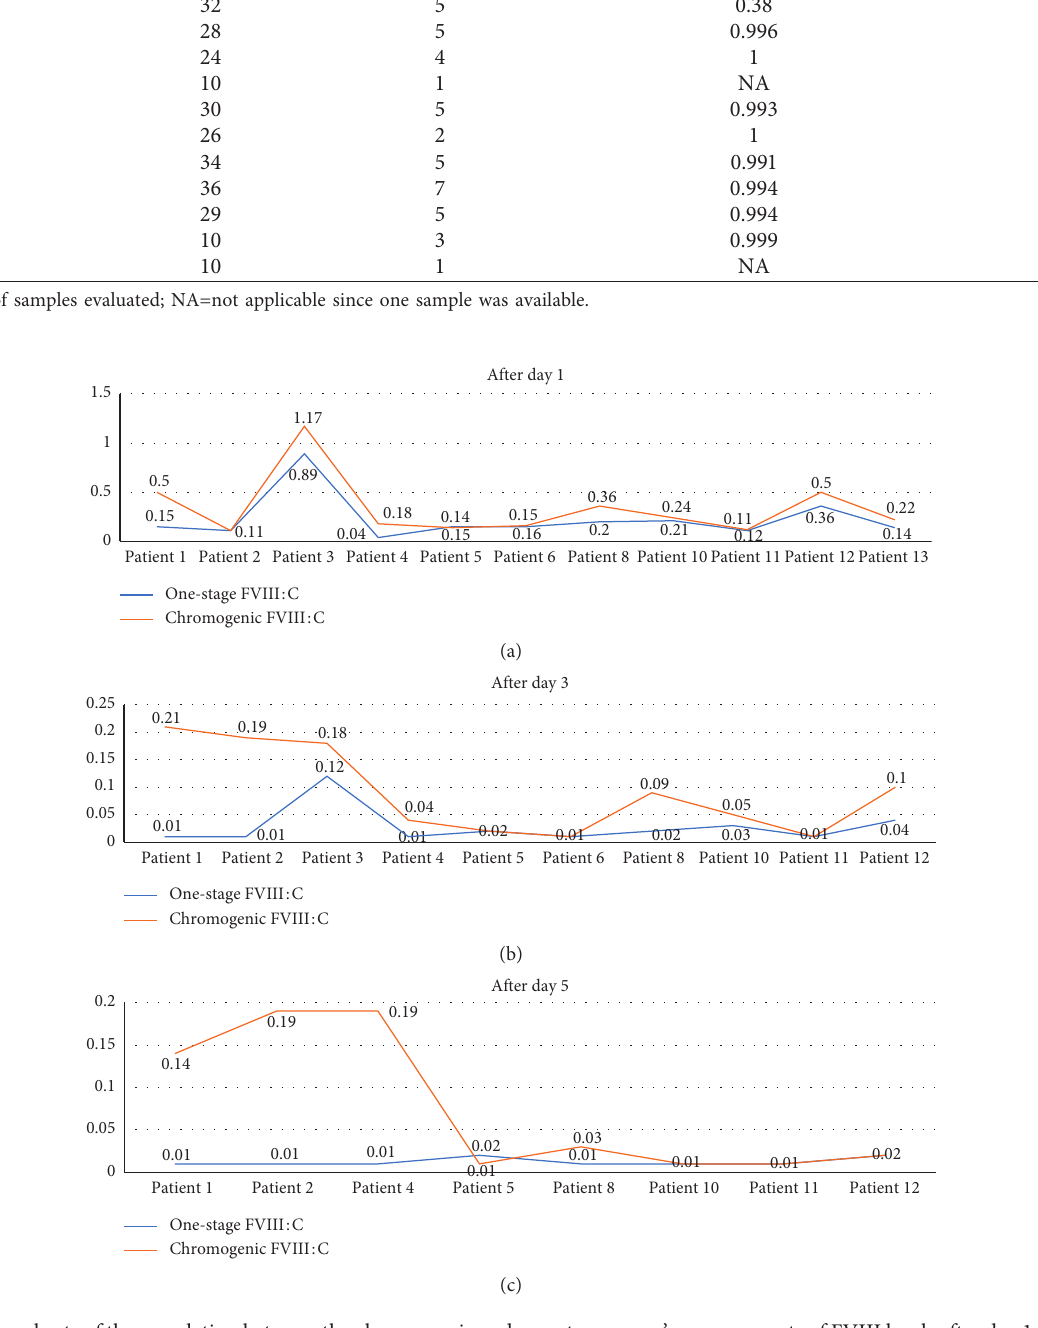
Figure 2: Line charts of the correlation between the chromogenic and one-stage assays’ measurements of FVIII levels after day 1, day 3, and day